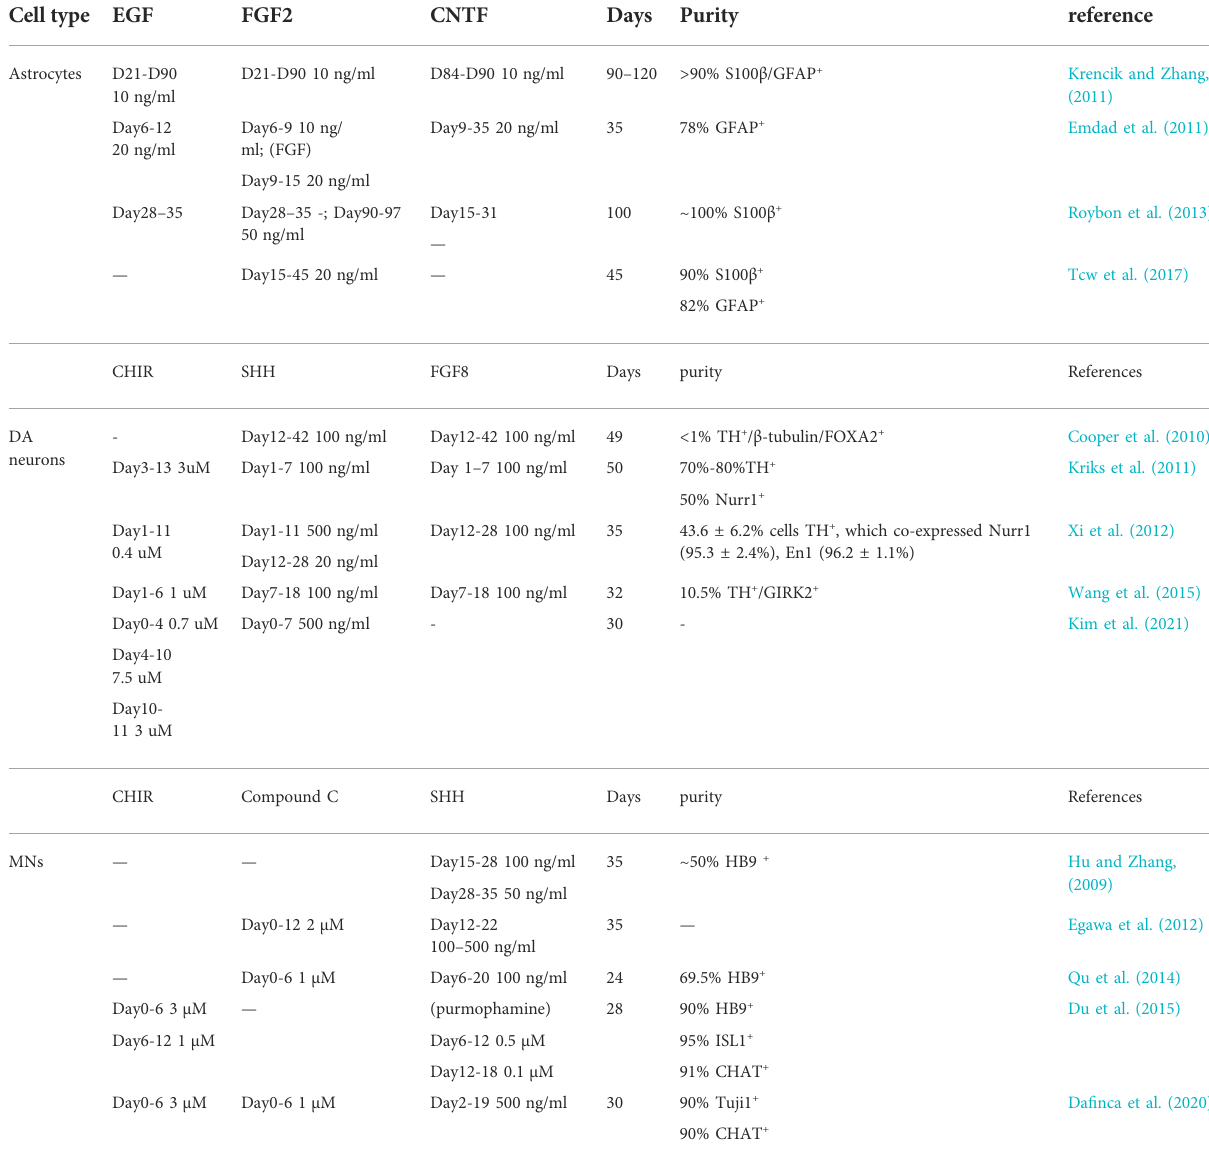
TABLE 1 Protocols of Astrocytes, DA neurons and MNs